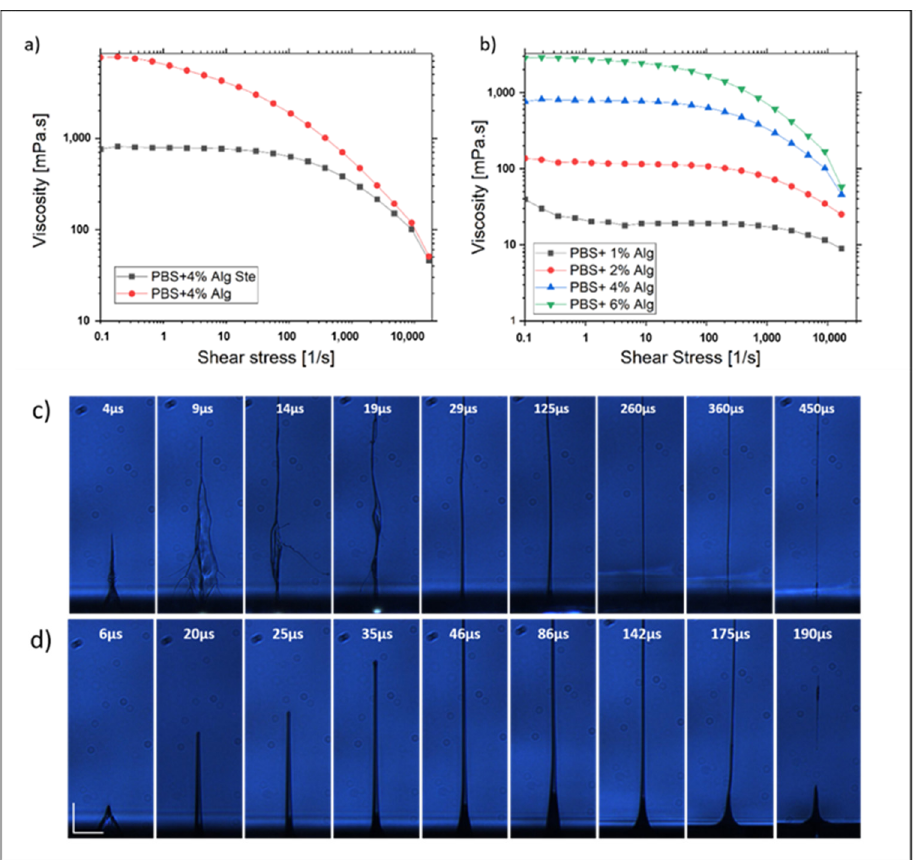
Figure 10. Rheological study of the bio-ink: ( a ) impact of the sterilization process on the bio-ink viscosity, ( b ) impact of the alginate percentage on the bio-ink viscosity. Jetting dynamic study by real-time visualizations for an energy of 17 μ J ( c ) 2% alg PBS bio-ink and ( d ) 4% alg PBS bio-ink (scale bar: 40 μ m).